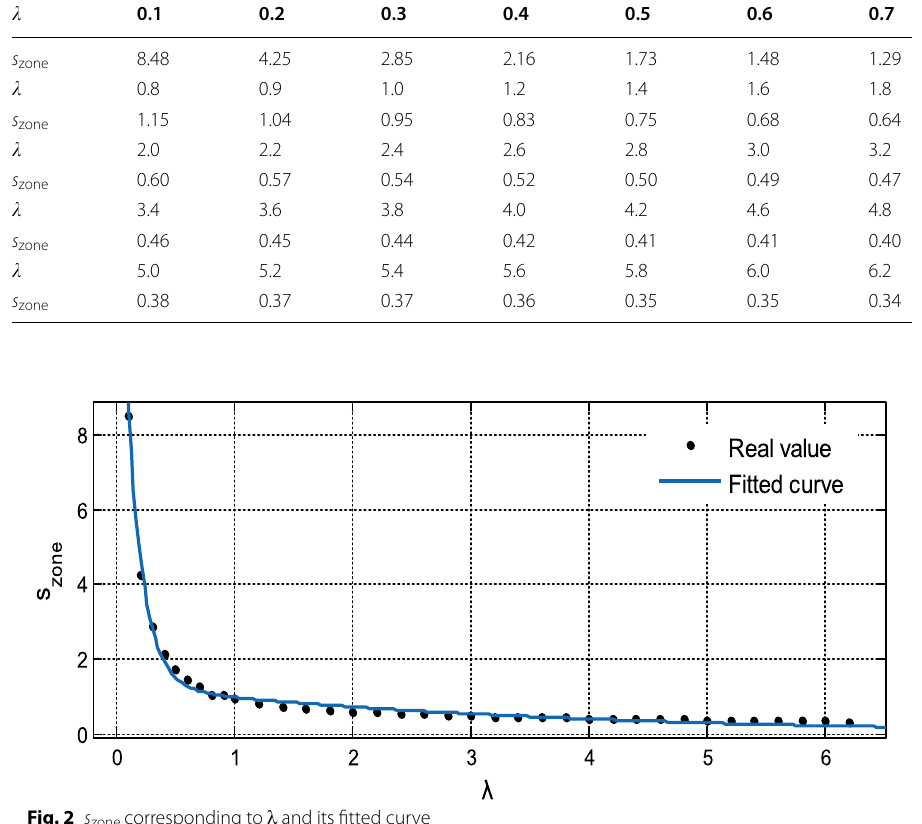
Table 1 The different s zone corresponding to the different scaling parameters of GLHS function